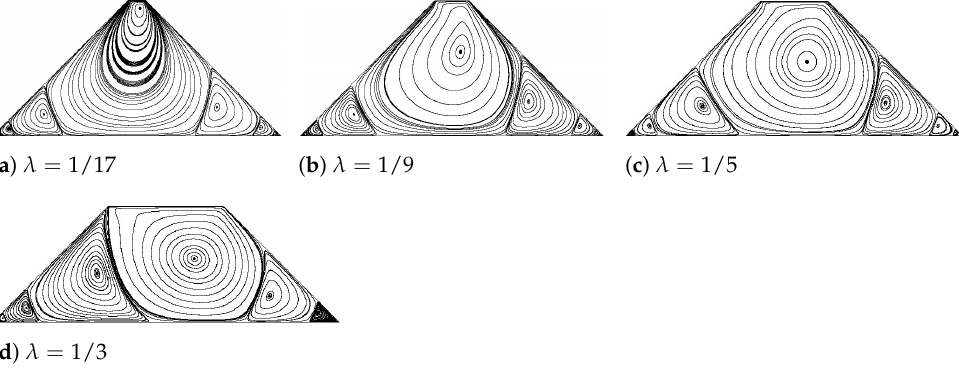
Figure 11. Streamlines inside the pyramid-shaped trapezoid with various values of λ at Re =